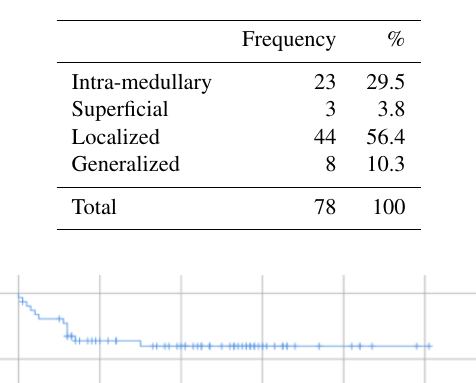
Table 3. Cierny–Mader classification.